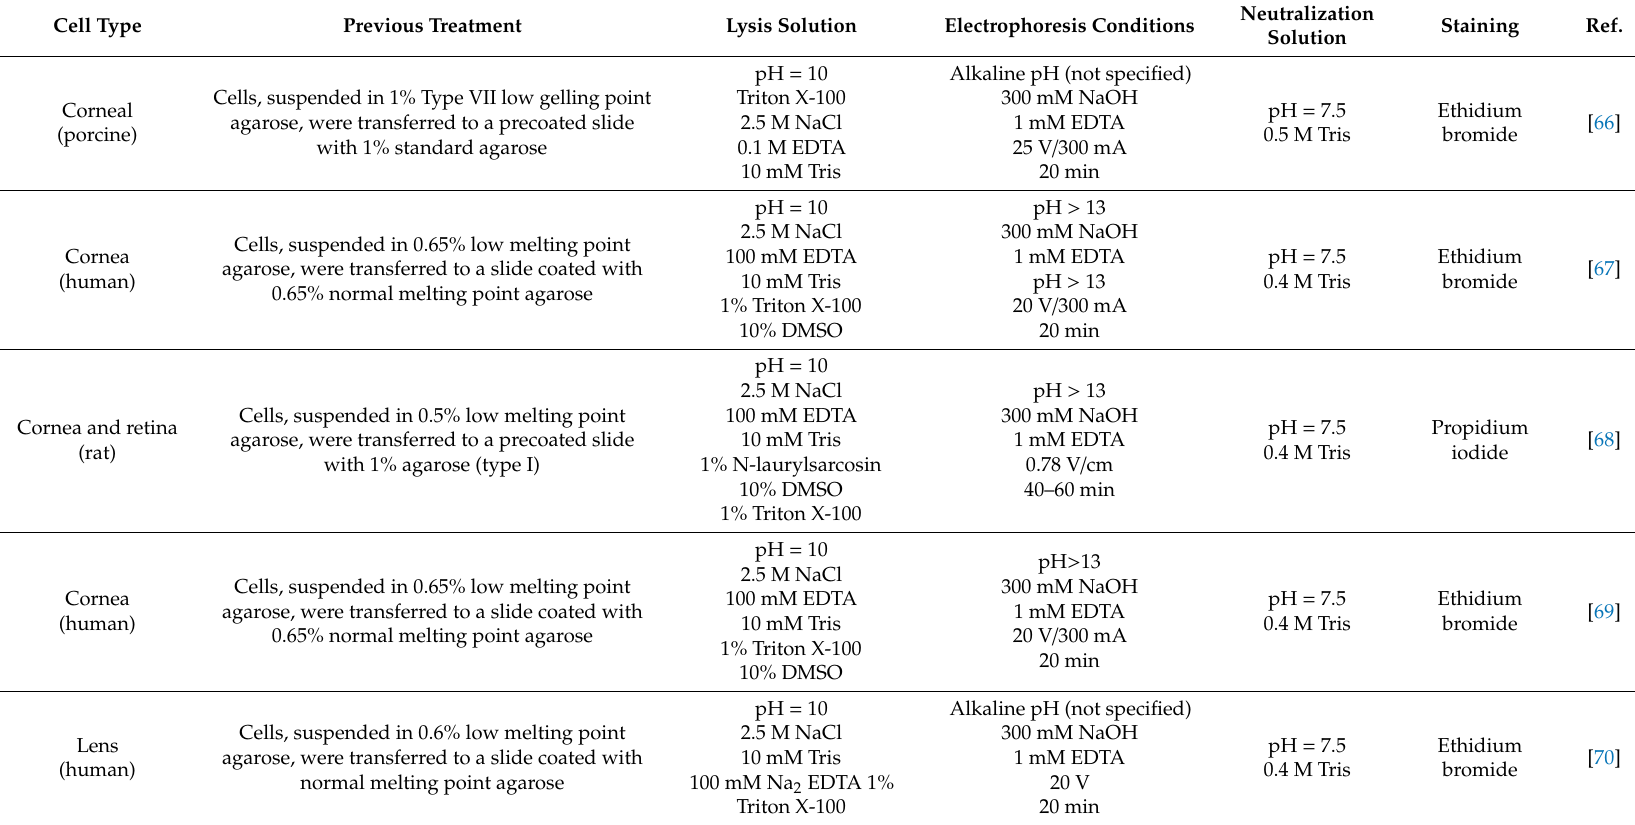
Table 2. Summary of the comet assay protocols in epithelial